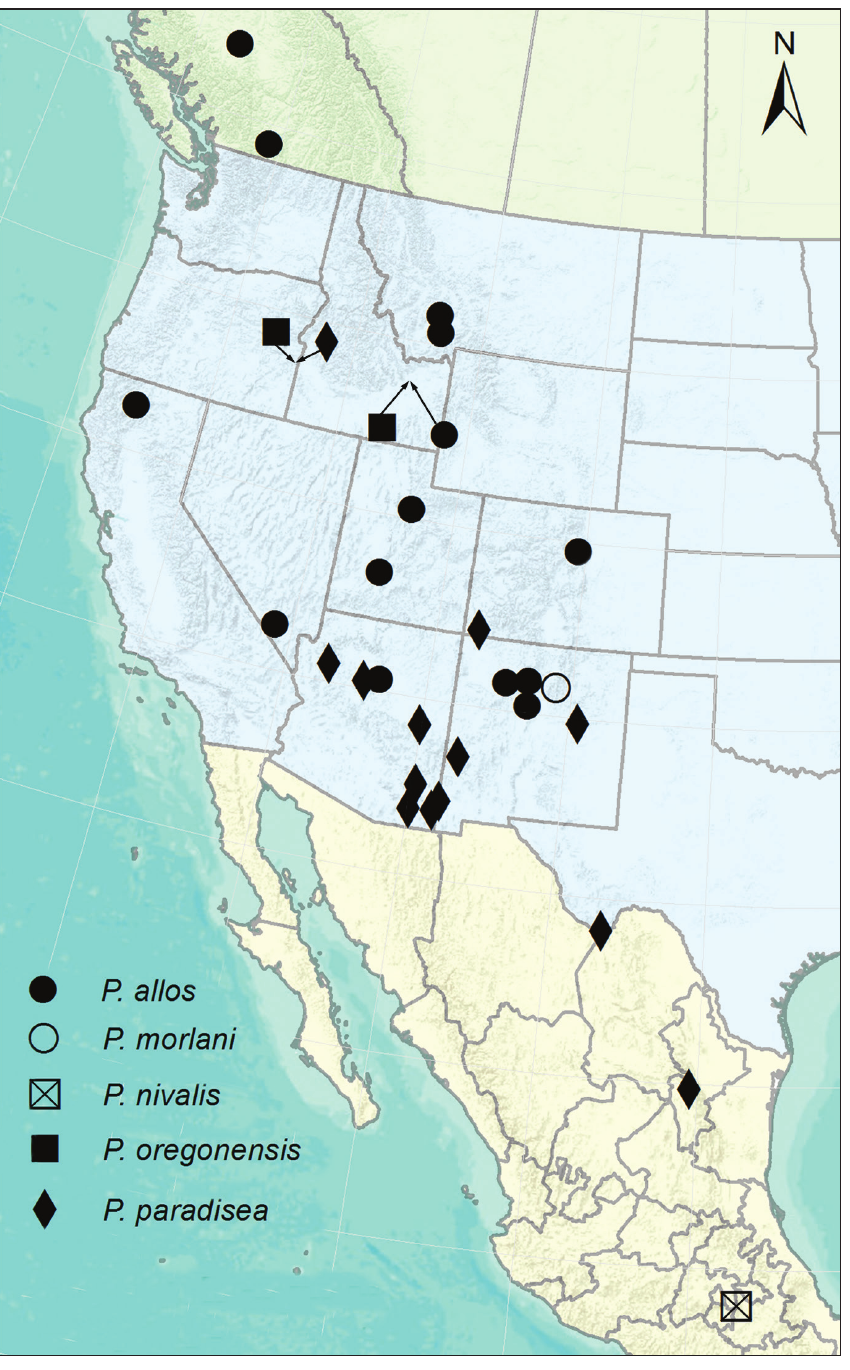
Figure 1. Distribution of Phalacropsylla species in the Canada, Mexico, and the Western United States. Arrows define same locality for two